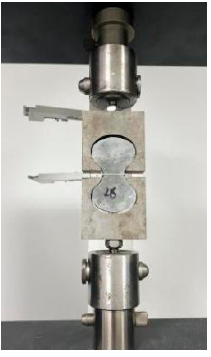
Figure 4. Steel fiber pullout test.